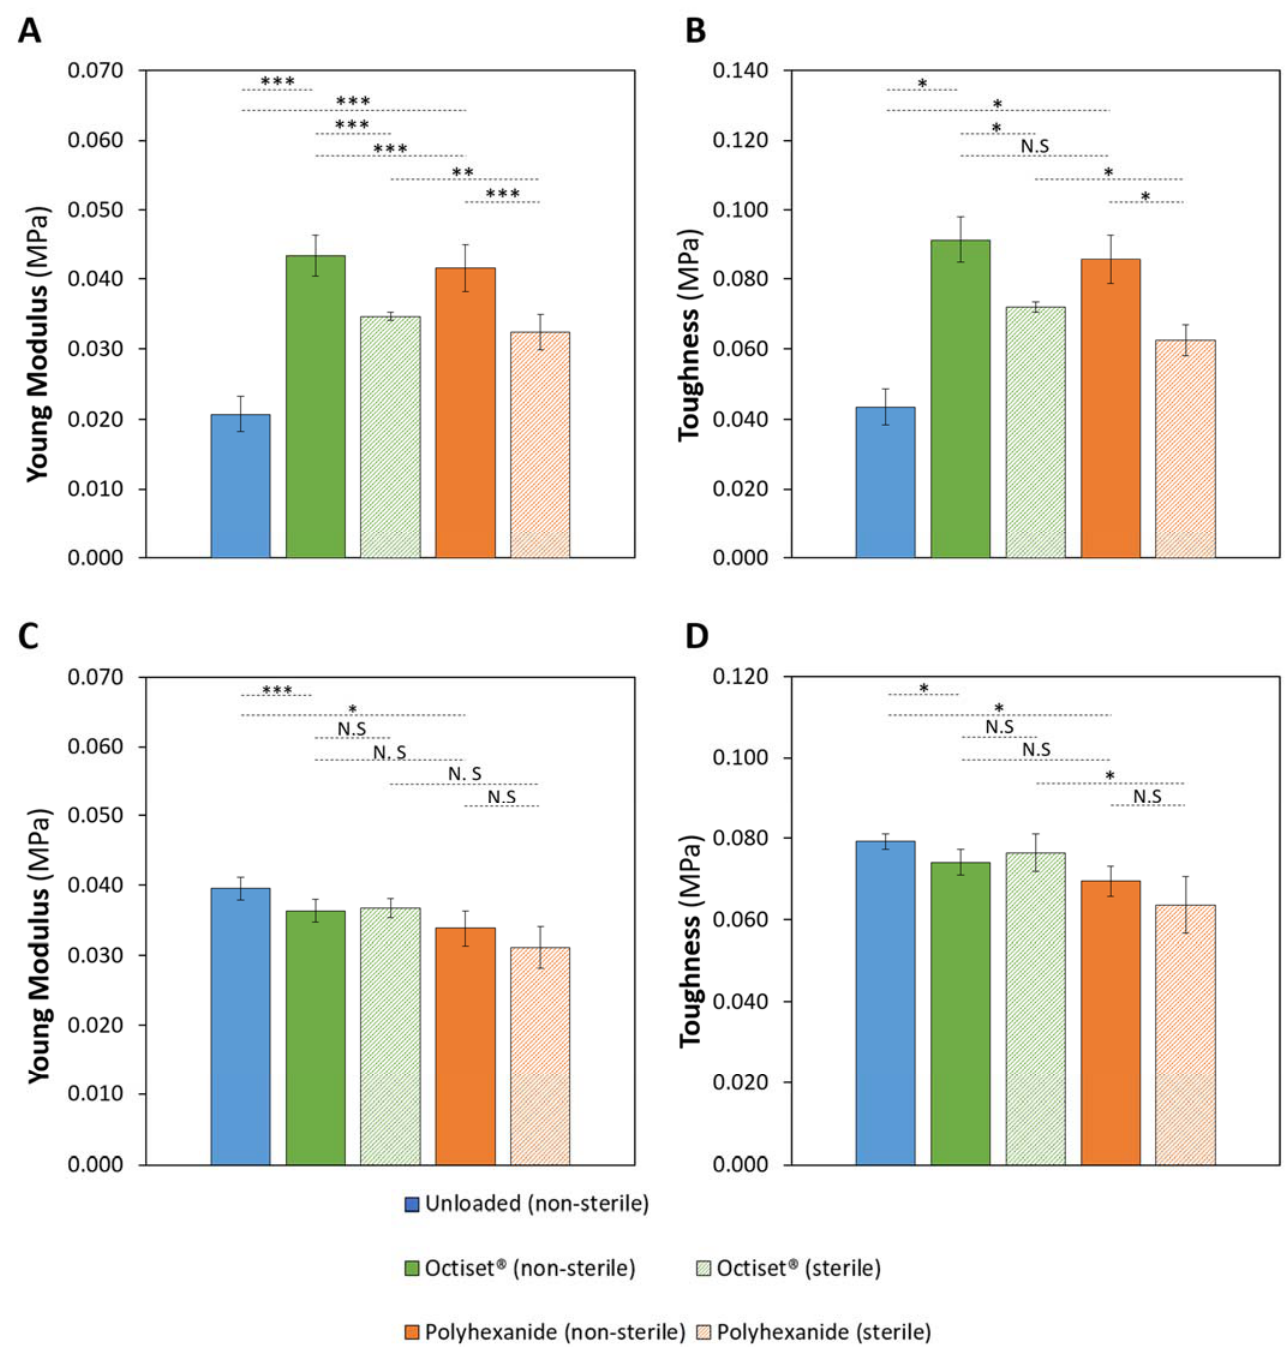
Figure 5. The Young’s modulus ( A , C ) and toughness ( B , D ) values determined for the strain range 0–20% of non-loaded and drug-loaded sterile and non-sterile CS ( A , B ) and C ( C , D ) hydrogels. Error bars correspond to ± standard deviations (n = 4). Statistical analysis was performed using the Student t-test or Wilcoxon signed-rank test, with significance set at * p < 0.05, ** p < 0.01, *** p < 0.001. N.S. = not significant.